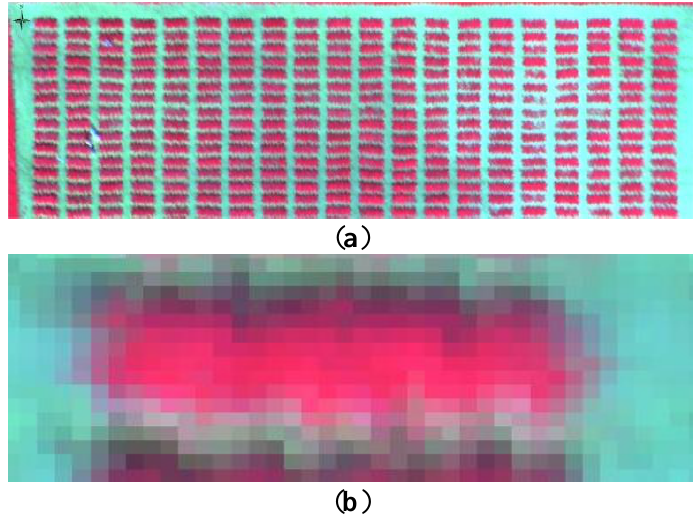
Figure 2. ( a ) Hyperspectral imagery acquired from the study area; ( b ) Detail of a single plot.